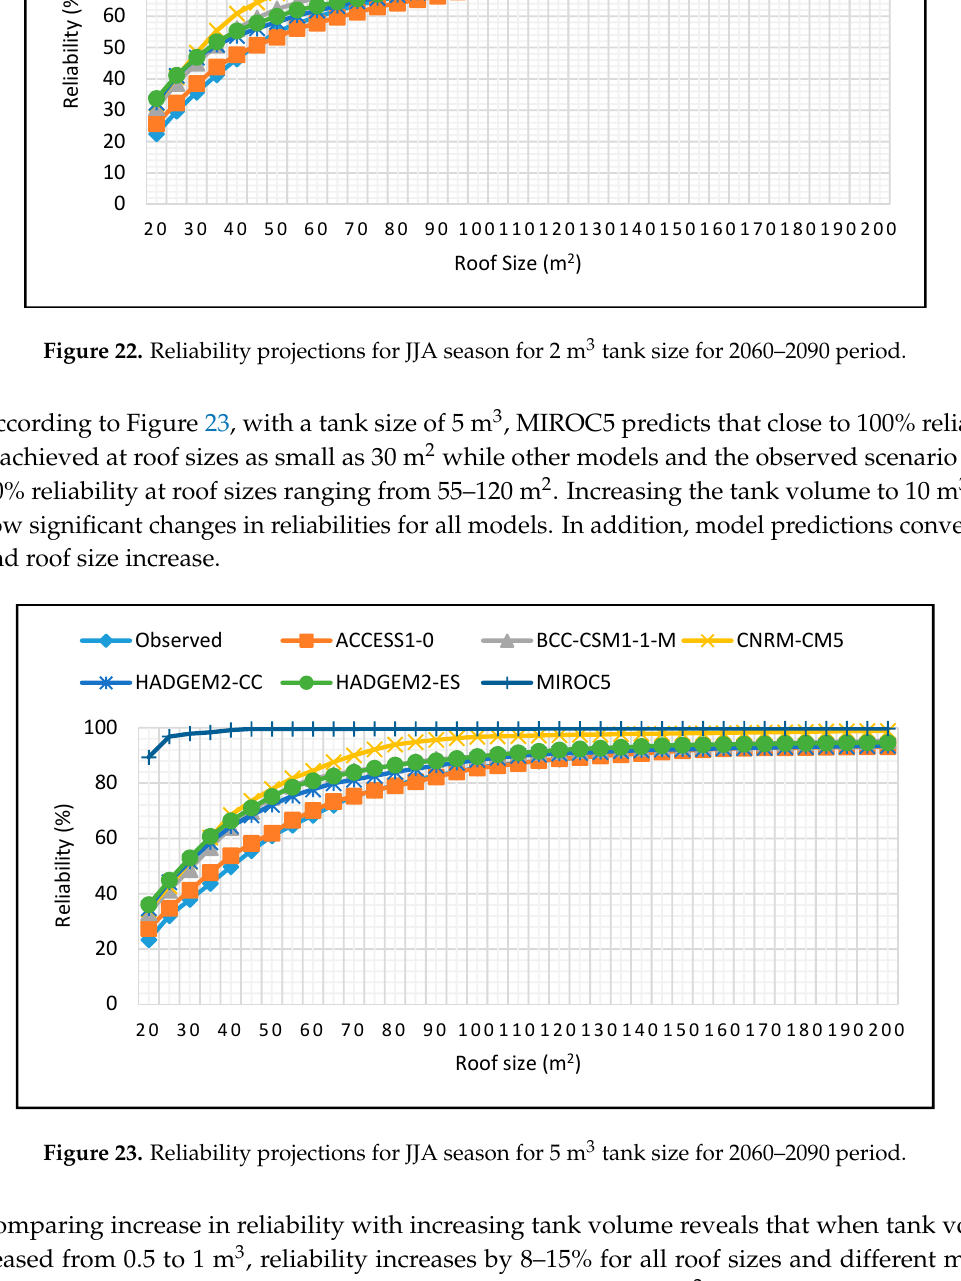
Figure 21. Reliability projections for JJA season for 1 m 3 tank size for 2060–2090 period.